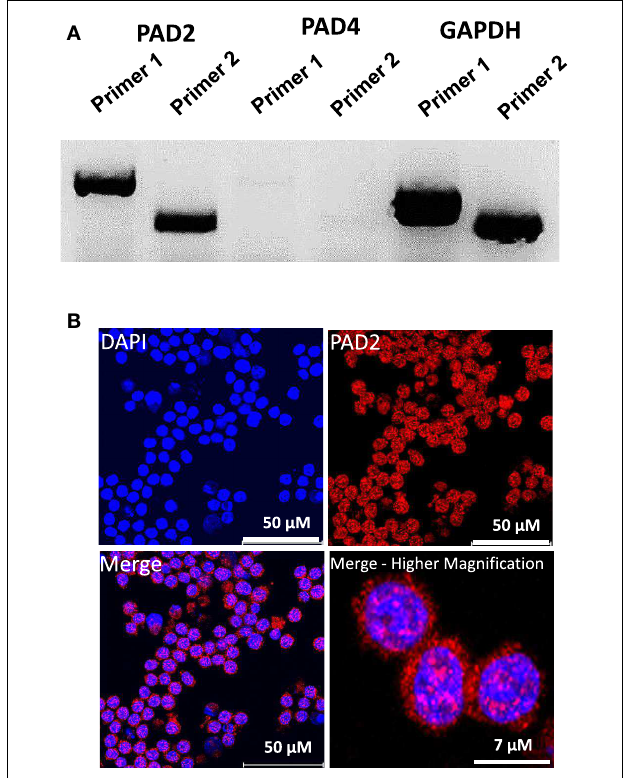
FIGURE 2 | PAD2 expression in cultured RAW 264.7 macrophage cells. (A) RT-PCR for PAD2 and PAD4 mRNA expression in cultured RAW 264.7 macrophages.Two unique primer sequence sets were used to test for PAD2 and PAD4 mRNA expression levels. RAW 264.7 macrophages were found to strongly express PAD2 mRNA. GAPDH mRNA expression levels were used as the internal control for RT-PCR. (B) Anti-PAD2 immunofluorescence labeling shows positive staining in the nucleus and cytoplasm of RAW 264.7 macrophages. Nuclei are stained with